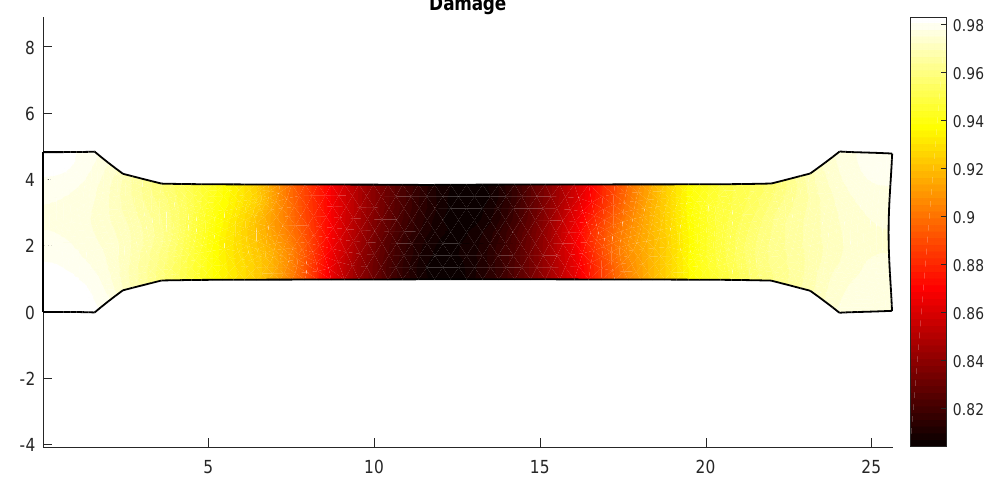
Figure 6. Damage field at final time over the deformed configuration.